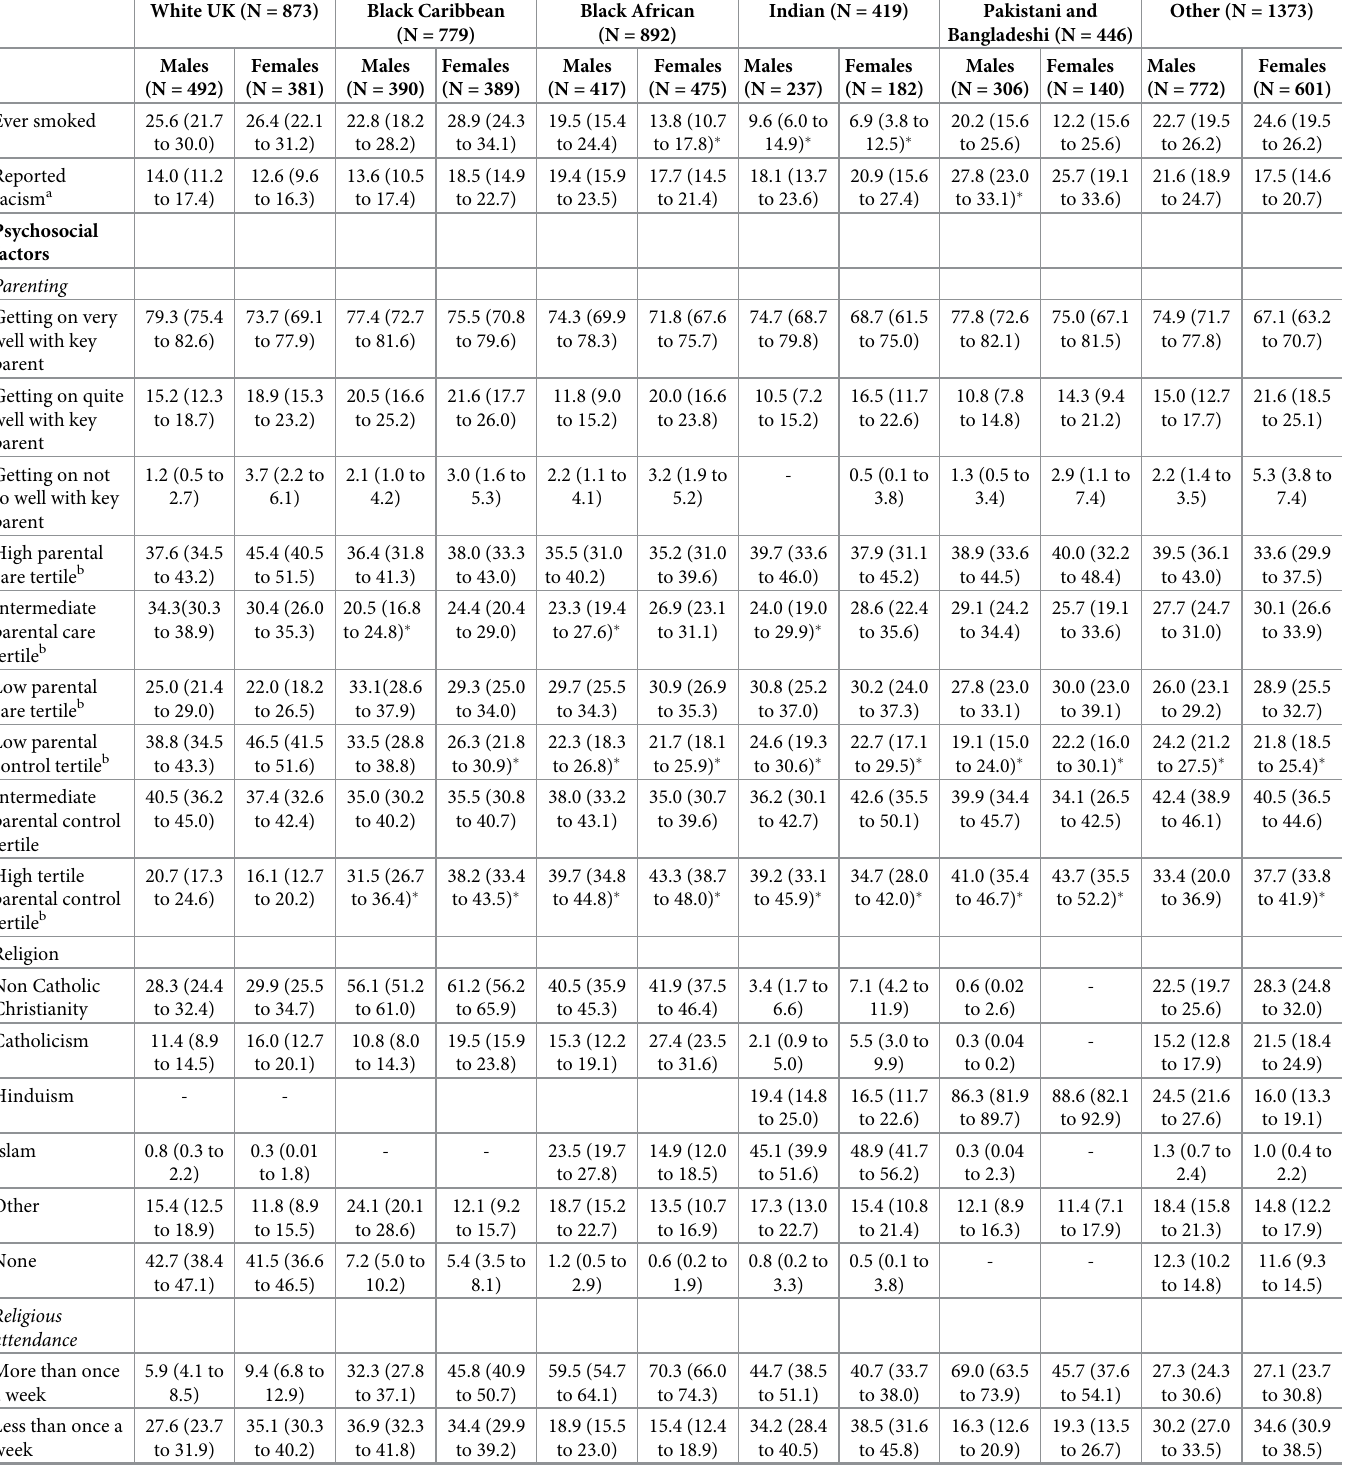
Table 2. Sample profile at 11-13y by gender and ethnicity. The Determinants of Adolescent (now Adult) Social well-being and Health study. White UK (N = 873) Black Caribbean (N =